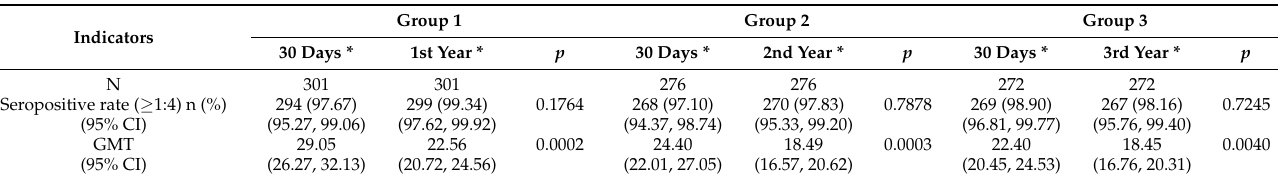
Table 2. Comparison of antibody levels between subjects at different time points after vaccination and 30 days after basic